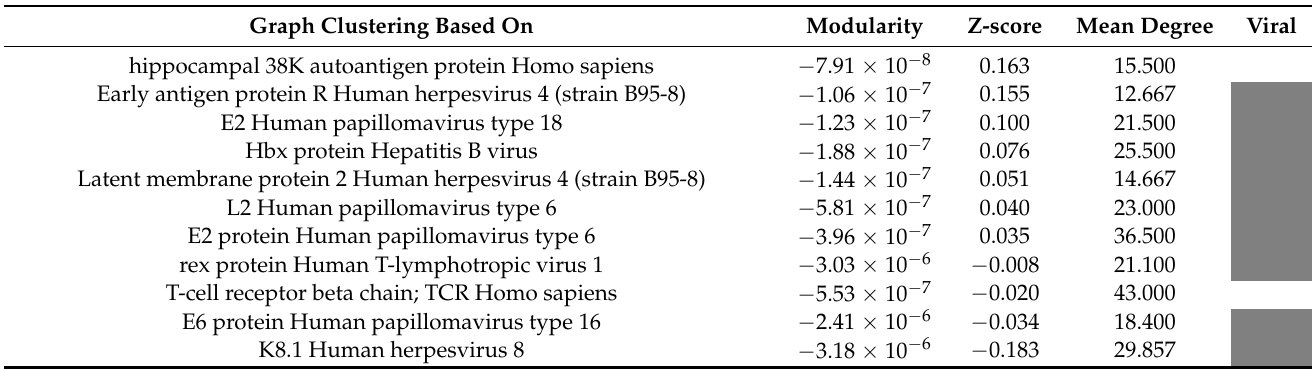
Table 1. Cont. Graph Clustering Based On